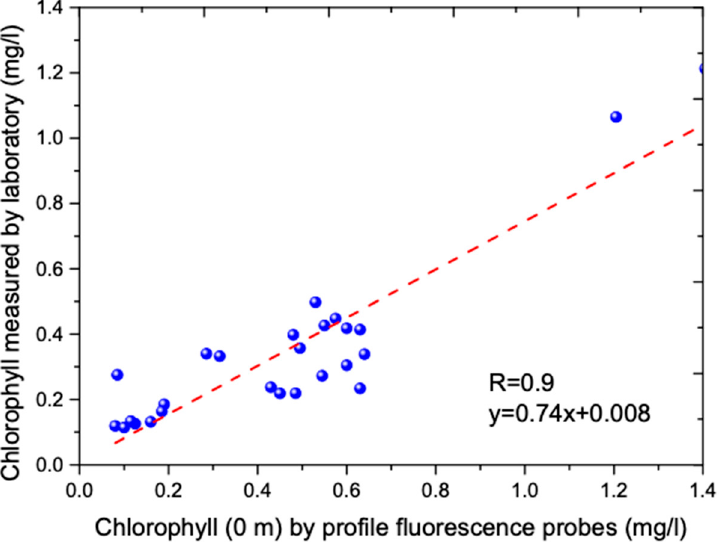
Figure 2. Line regression between laboratory scanning spectrofluorometer and in situ profile chlorophyll measurements (0 m) by profile chlorophyll fluorescent probes.